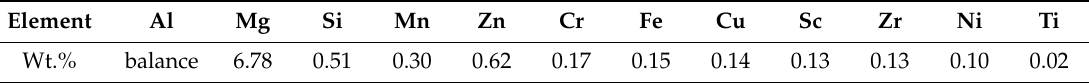
Figure 1. The image of the cross-section of the Al alloy welded joint. Table 1. The concentration of the alloying elements in the composition of the alloy.